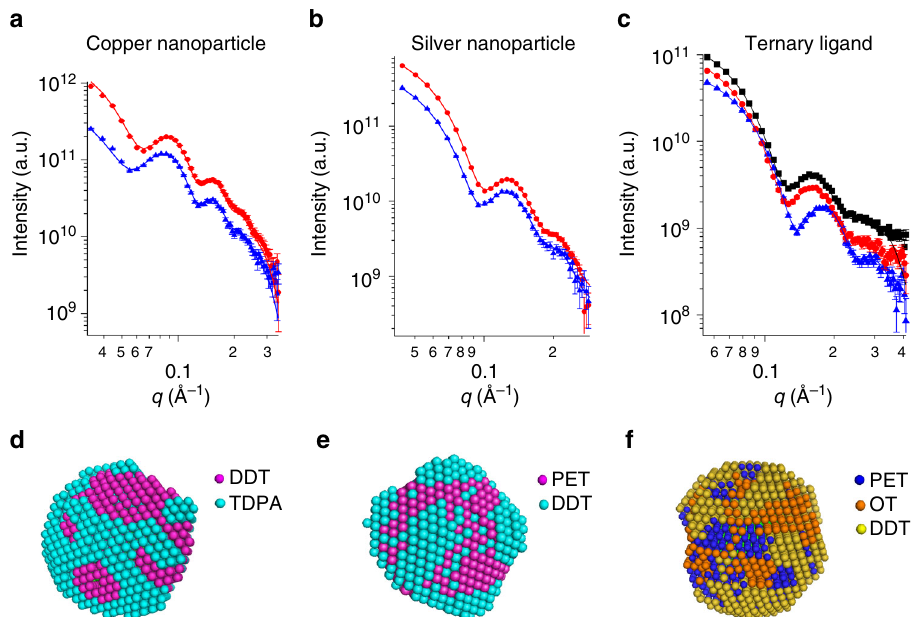
Fig. 5 SANS data and models for different types of nanoparticles. . a SANS data and fi ts for TDPA- and dDDT-coated copper nanoparticles. The red curve stands for the measurements in deuterated toluene while blue curve is for the measurements in a mixture of deuterated (80%) and hydrogenated (20%) toluene. Corresponding 3D model is in d with the blue beads stand for longer ligand (TDPA) and red stands for shorter ligand (dDDT). b SANS data and fi ts for dPET- and DDT-coated silver nanoparticles. The solvent conditions are the same as copper nanoparticle samples. Corresponding 3D model is in e with the blue beads stand for longer ligand (DDT) and red stands for shorter ligand (dPET). c SANS data and fi ts for ternary LS gold nanoparticles, in which red dots and curves represent the data and fi ts of PET-dOT-DDT nanoparticles, blue ones are for PET-OT-dDDT nanoparticles, and black ones are for dPET- OT-DDT nanoparticles. The solvents for all the measurements are deuterated toluene. Corresponding 3D model is in f . Yellow, orange, and blue beads stand for DDT, OT, and PET ligands, respectively. The error bars in the SANS data represent standard deviations of neutron counts and are explained in detail in Method